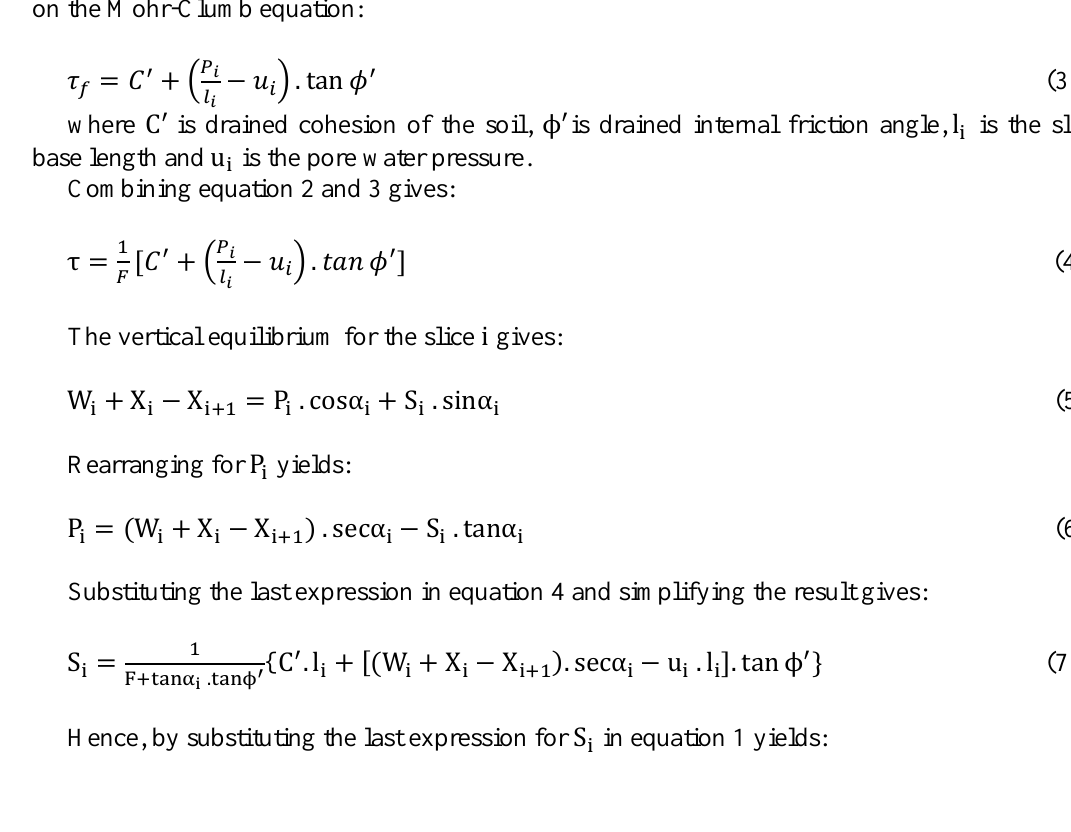
Figure 2. Free body diagram of a